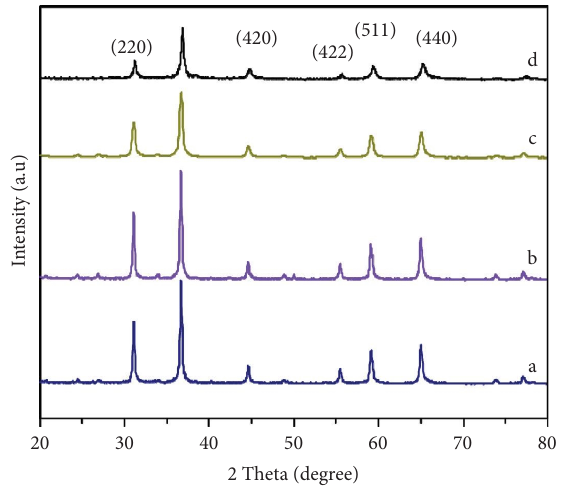
Figure 1: XRD pattern of (a) pristine ZnCr Zn 1 − x Mn x Cr 2 O 4 ( x � 0.01 to